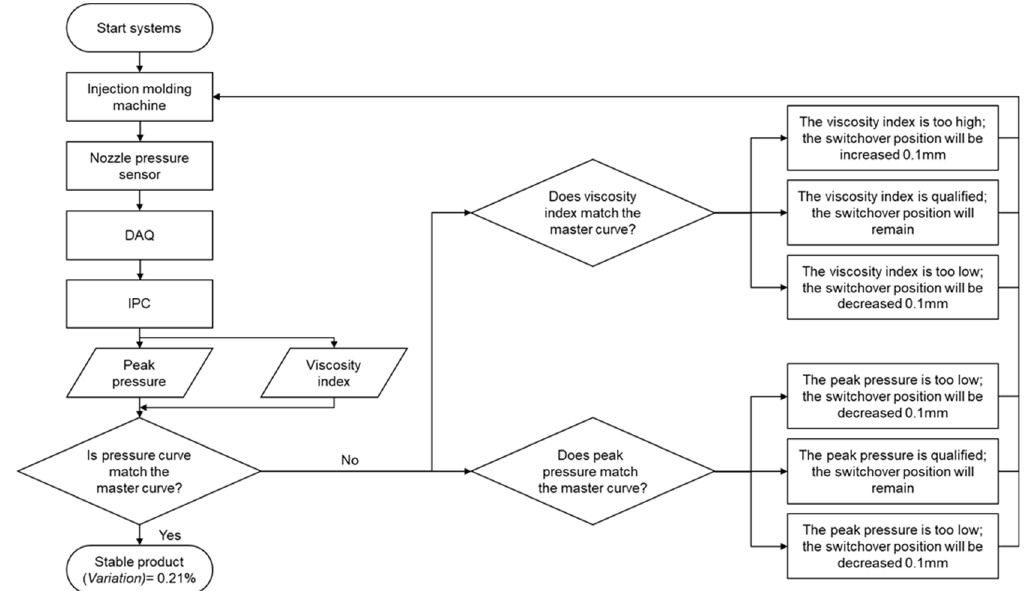
Figure 7. Flow chart of the control system. Table 8. The experimental parameters without the adaptive adjustment system.